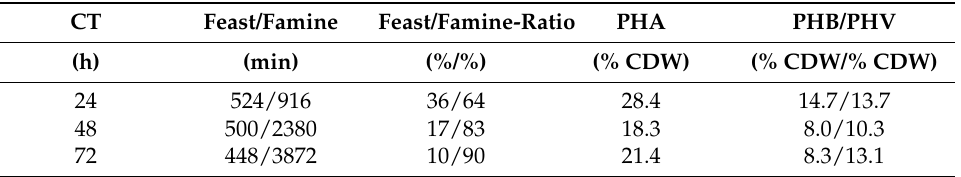
Table 7. PHA production in dependence of the cycle